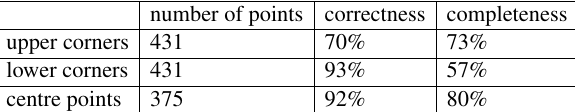
Table 5. Completeness and correctness for upper and lower cor- ners and centre points in the qhole data set.